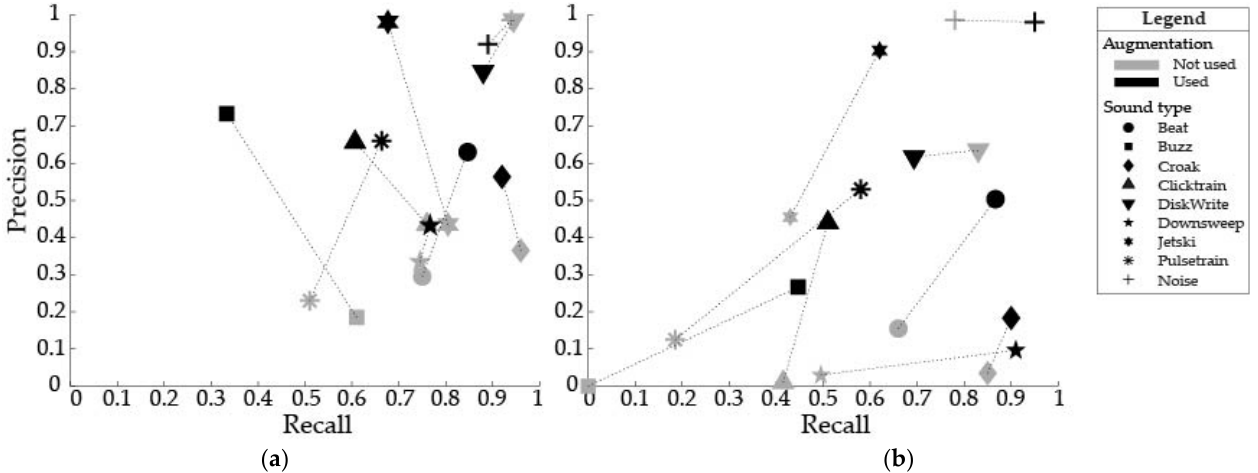
Figure 4. Average (n = 3) classifier precision and recall with and without image augmentation (black and light gray shapes, respectively) to train the classifier. Results are presented when classifying: ( a ) the ~91,300 train/test dataset detection images and ( b ) the ~129,000 evaluation dataset detection images. Three noise categories (Low Frequency Noise, Blank/noise, and Random Noise) are combined to make the figures more clear. Table 2. Overall classifier accuracy (total correctly labeled detection images/total detection images) for the three different times (i.e., three trials) all the detection images from both datasets—train/test and evaluation—were classified by the data- augmented, trained classifier, as well as the average overall classifier accuracy for each dataset.